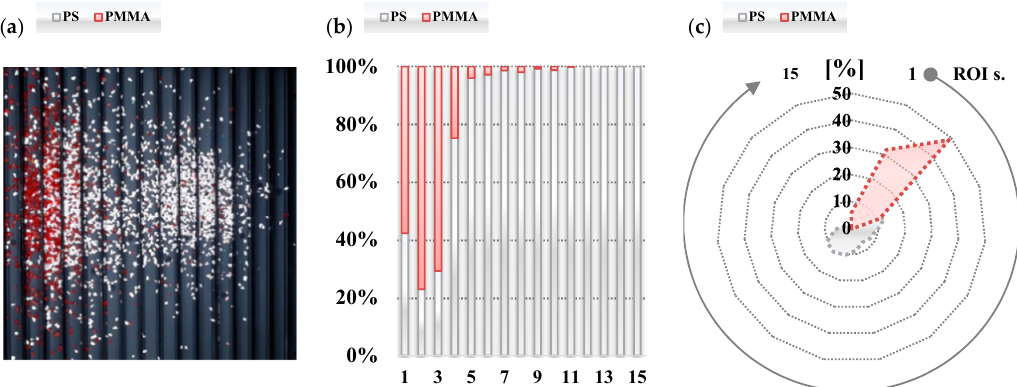
Figure 11. Results of processing the raw image ( a ); percentage material content in each ROI ( b ) and percentage material content related to total amount of each material ( c ) for the corona charging mode.